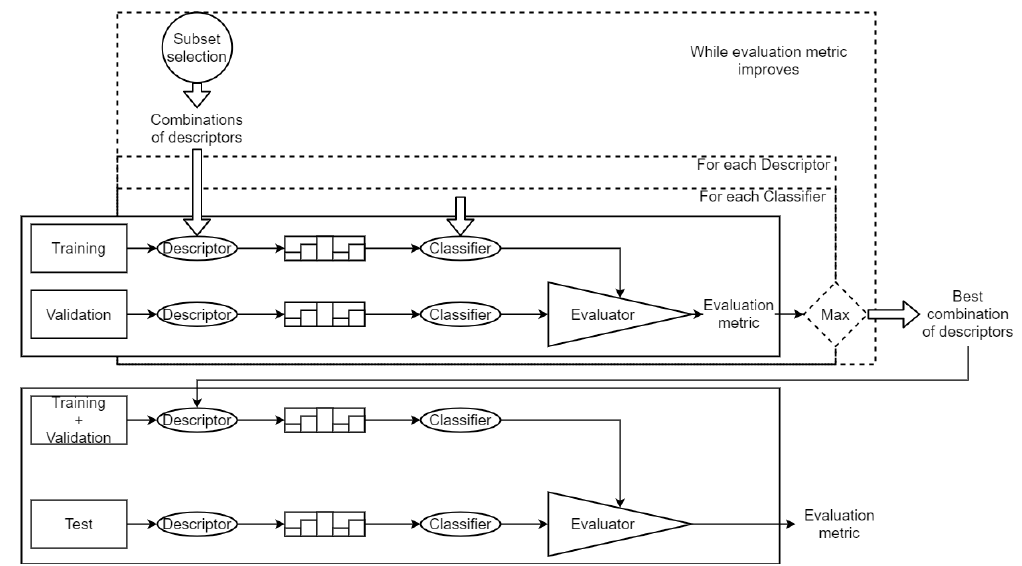
Figure 4. Full pipeline of the proposed method, including training, validation, and